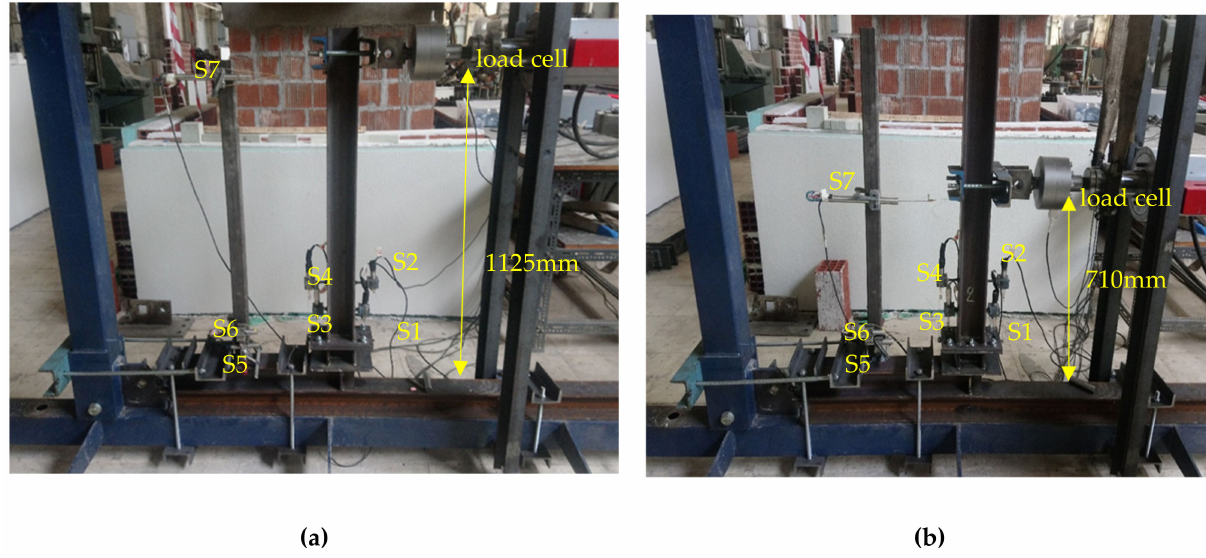
Figure 14. Experimental setup for ( a ) the JL-4 and ( b ) the JL-6 steel bolted joint specimen. The hydraulic actuator was horizontally positioned at a 1125 mm distance from the column in specimen JL-4 and 710 mm from the column in JL-6, respectively. The employed instrumentation comprised seven LVDTs in total to measure the various displacements of the joint components: S1 and S3 for the vertical displacement of the lower bolted end plate, S2 and S4 for the vertical displacement of the upper bolted end plate, S5 for the horizontal displacement of the lower bolted end plate, S6 for the horizontal displacement of the upper bolted end plate, and S7 for the horizontal displacement of the beam’s